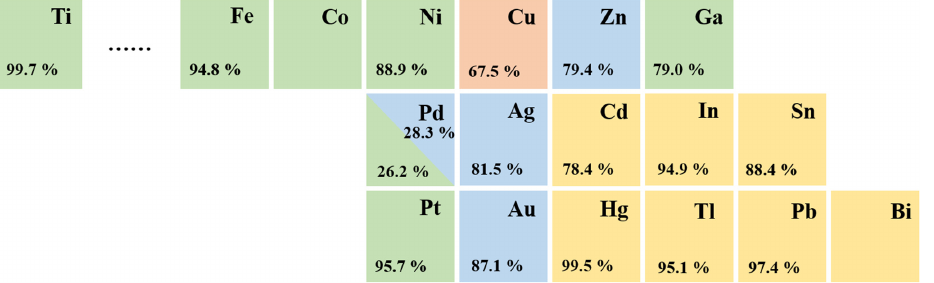
Figure 2. Periodic table and Faradaic efficiencies of various metals depending on the major products in CO 2 electroreduction: CO (blue); HCOOH (yellow); mixed hydrocarbons (red); H 2